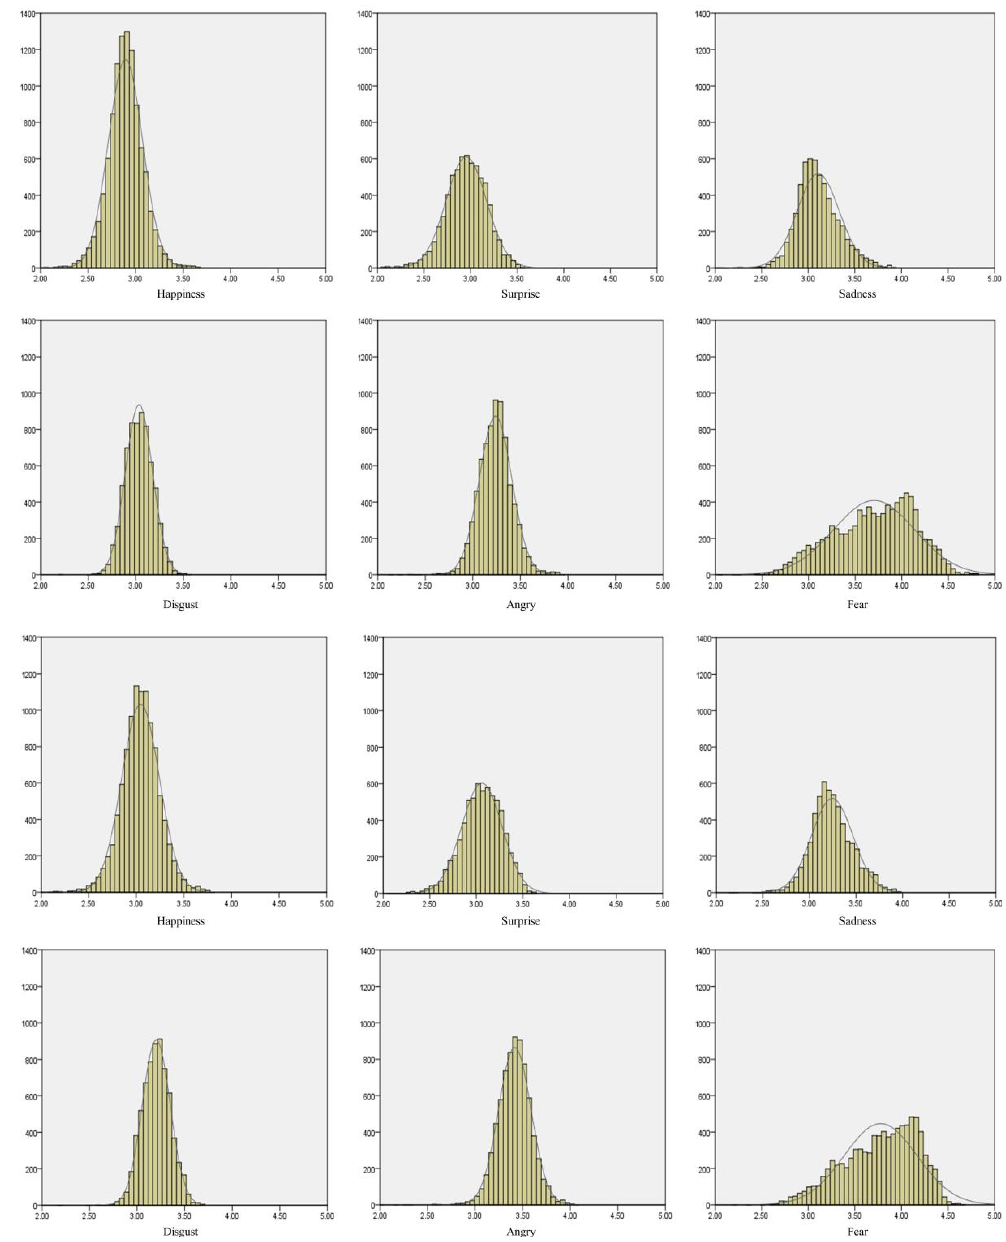
Figure 2. Six emotions and pupil dilation recording for both eyes. (The top six graphs are for left pupil; the bottom six graphs are for right eye. X-axis is pupil dilation/mm; Y-axis is